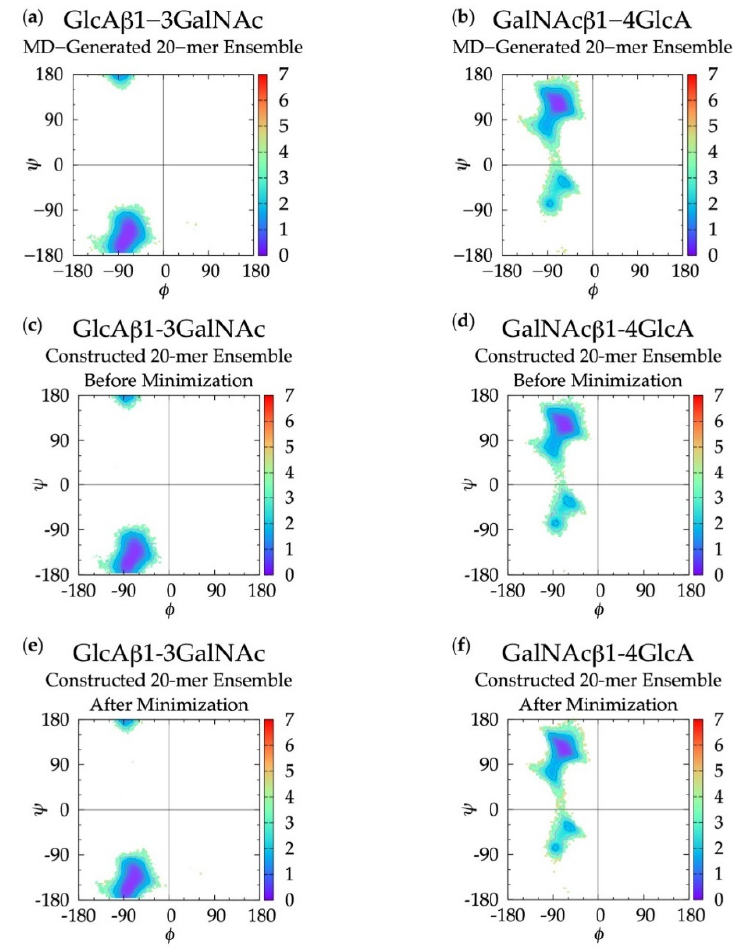
Figure 3. ∆ G ( φ , ψ ) in non-sulfated chondroitin 20-mer ensembles for aggregated GlcA β 1-3GalNAc and GalNAc β 1-4GlcA glycosidic linkage data ( a , b ) MD-generated ensembles, ( c , d ) constructed ensembles before minimization, and ( e , f ) constructed ensembles after minimization; contour lines every 1 kcal / mol. Table 1. Glycosidic Linkage Dihedrals ( φ , ψ ) 1 and Free Energy ( ∆ G ( φ , ψ ) kcal / mol) Minima. MD-Generated 20-mer